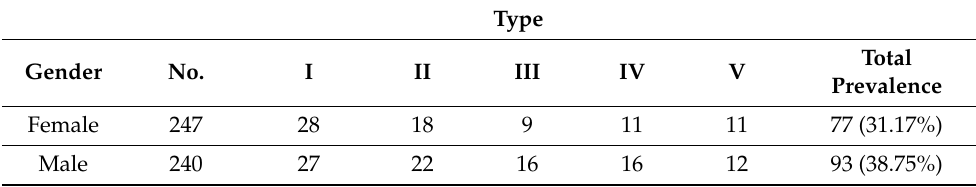
Table 3. Ponticulus posticus—prevalence by gender and morphologic types.